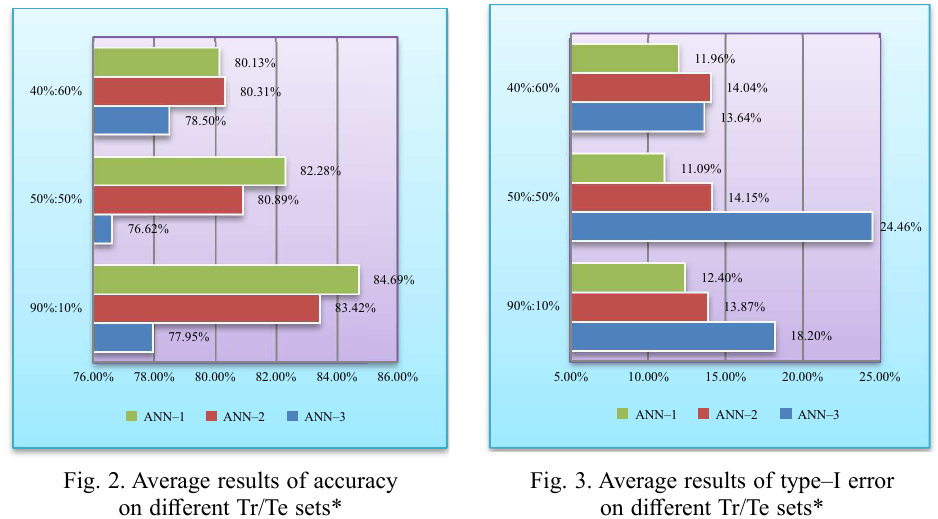
Fig. 2. Average results of accuracy on different Tr/Te sets*